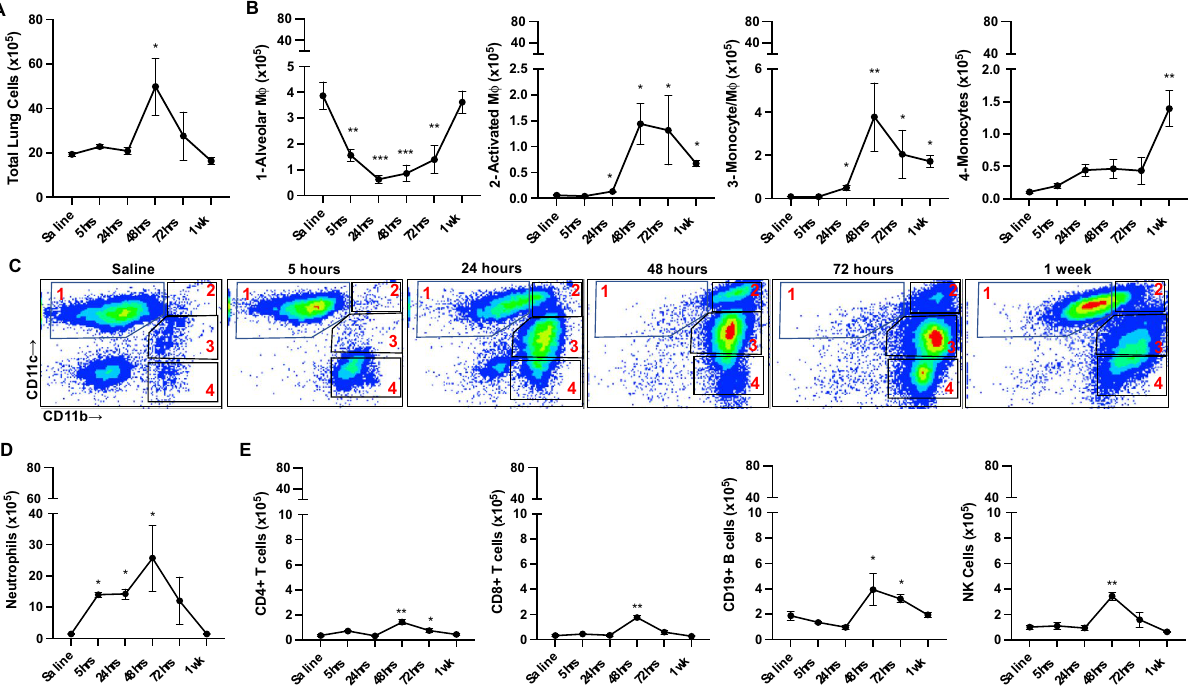
Figure 2. Normal homeostasis recovery trends in lung cell infiltrates over time following a one-time inhalation exposure to high-dose LPS. Lung cell populations determined by flow cytometry after removal of debris, doublets, and gating on live CD45 + cells (% population multiplied by total lung cells). Line graphs depict mean with SEM bars over time of total lung cells ( A ) and lung monocyte/macrophage subpopulations ( B ). ( C ) Gating strategy of lung monocyte/macrophage subpopulations : 1: Alveolar macrophages CD11c + CD11b lo , 2: Activated macrophages CD11c + CD11b hi , 3: Transitioning monocyte/macrophages CD11ci nt CD11b hi , 4: Monocytes CD11b hi CD11c - after exclusion of neutrophils. ( D ) Ly6G + neutrophil, and ( E ) lymphocyte populations shown. N = 24 mice (4 mice/time point). Statistical significance denoted versus saline/baseline as *p < 0.05, **p < 0.01, ***p < 0.001.